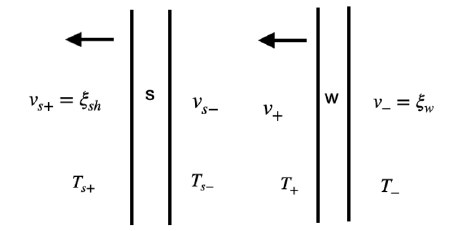
= 0 . 45 , v = 0 . 6 and v = 0 . 75 and three different kinds w w w